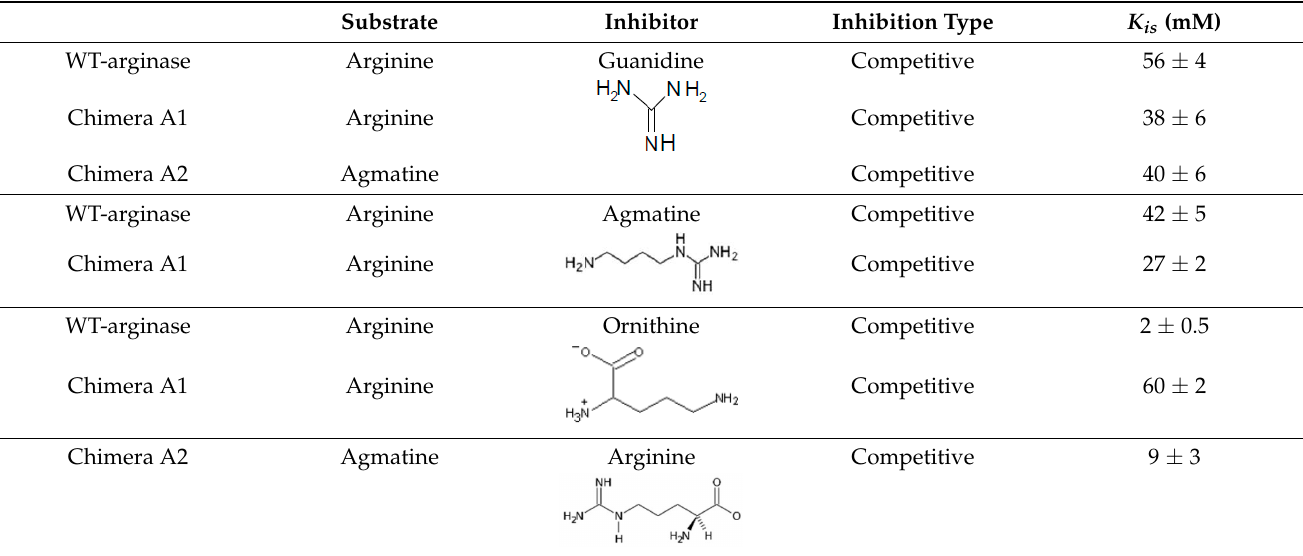
Table 3. Inhibition studies of the chimeric species A1 and A2 of human arginase type I.